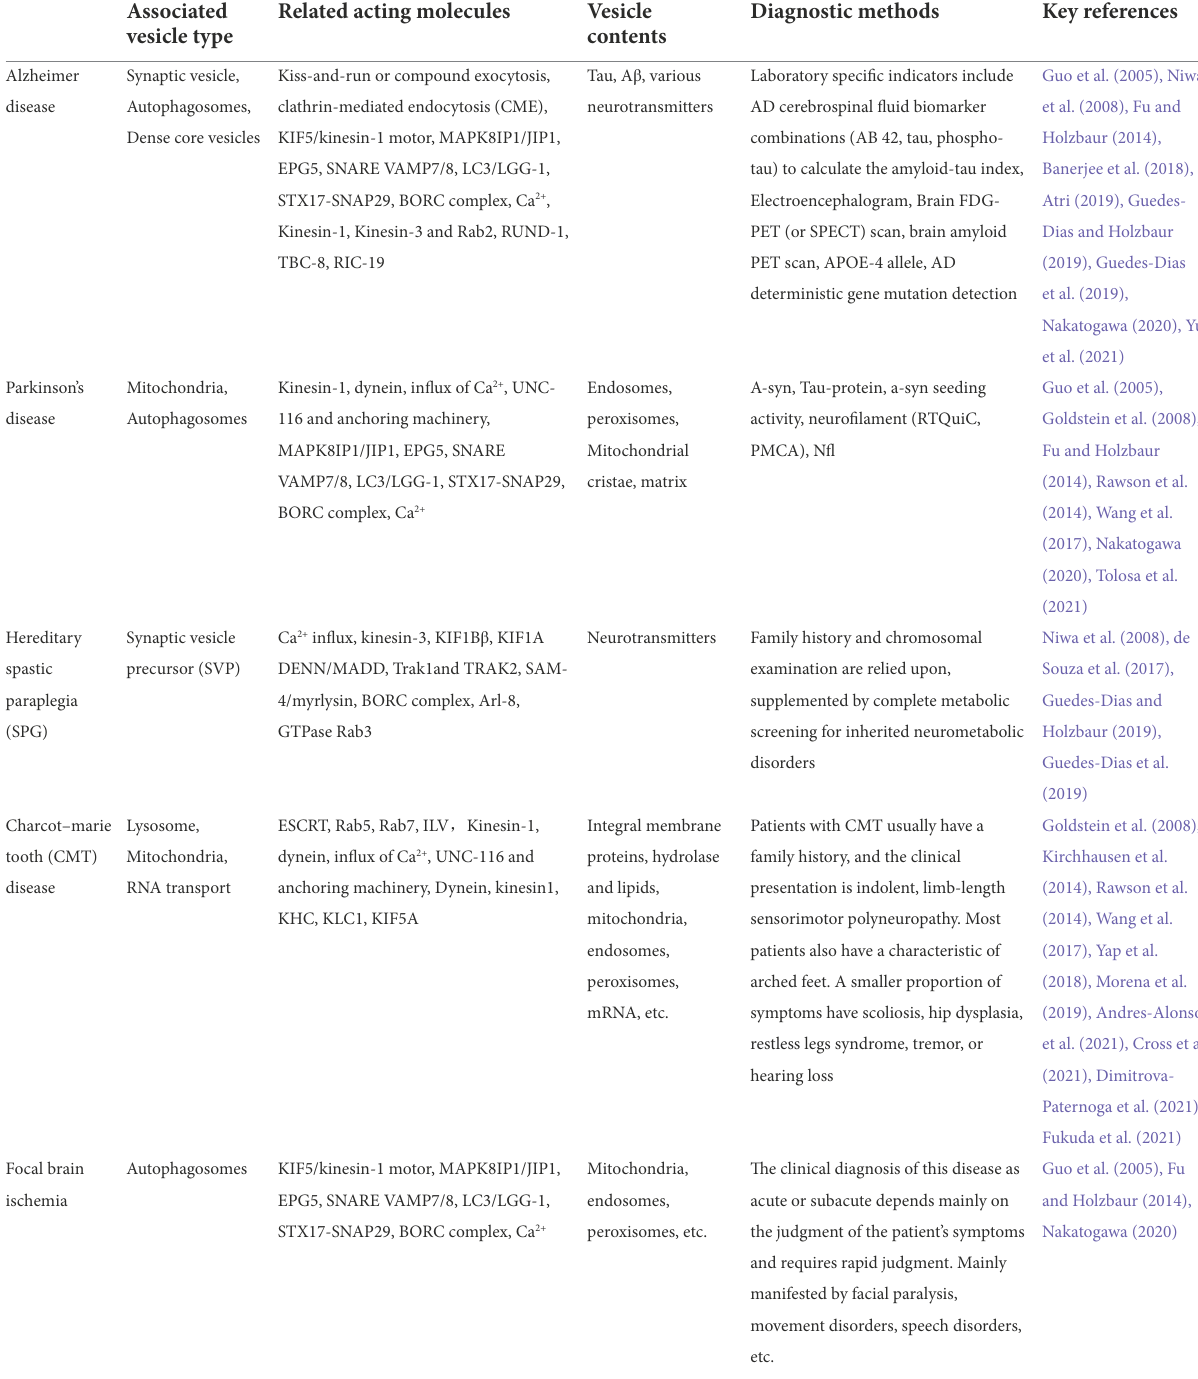
TABLE 1 Examples and characteristics of associated vesicles within